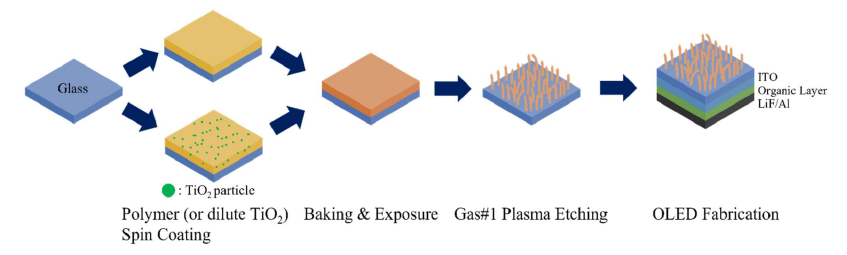
Figure 1. Schematic of the OLED fabrication process with RNSs (or diluted TiO 2